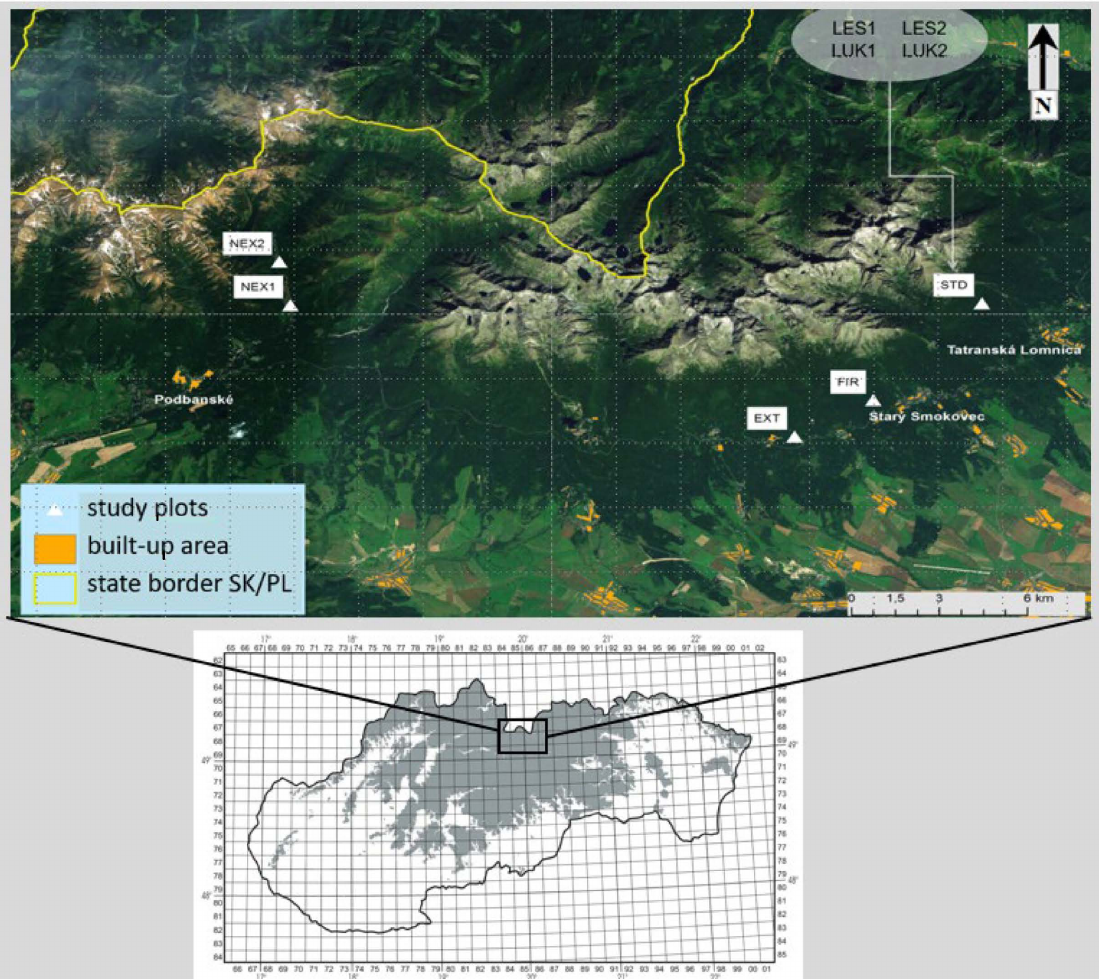
Figure 1. Study area with the selected study plots in the High Tatra Mountains.